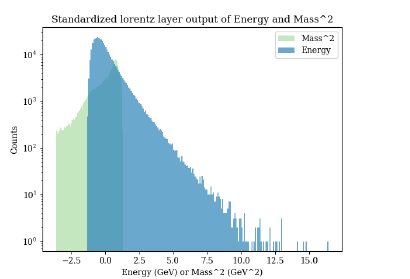
Figure 3. The raw output of the Lorentz layer calculations. The invariant calculation pro- duces negative quantities orders of magnitude larger than the energy output.